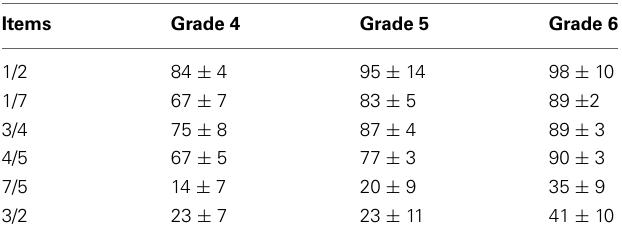
Table 3 | Mean percentage and standard deviation for the question: Draw a representation of the given